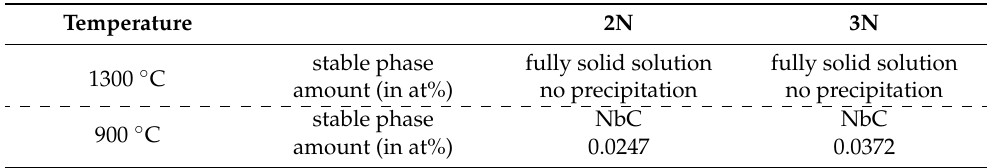
Table 2. The stable phase and its equilibrium amount at 1300 ◦ C and 900 ◦ C for Steels 2N and 3N, calculated via Thermo-Calc